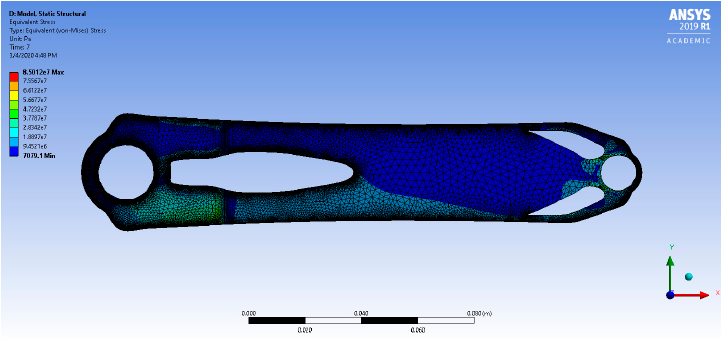
Figure 9. Stress distribution of the topology optimized design.